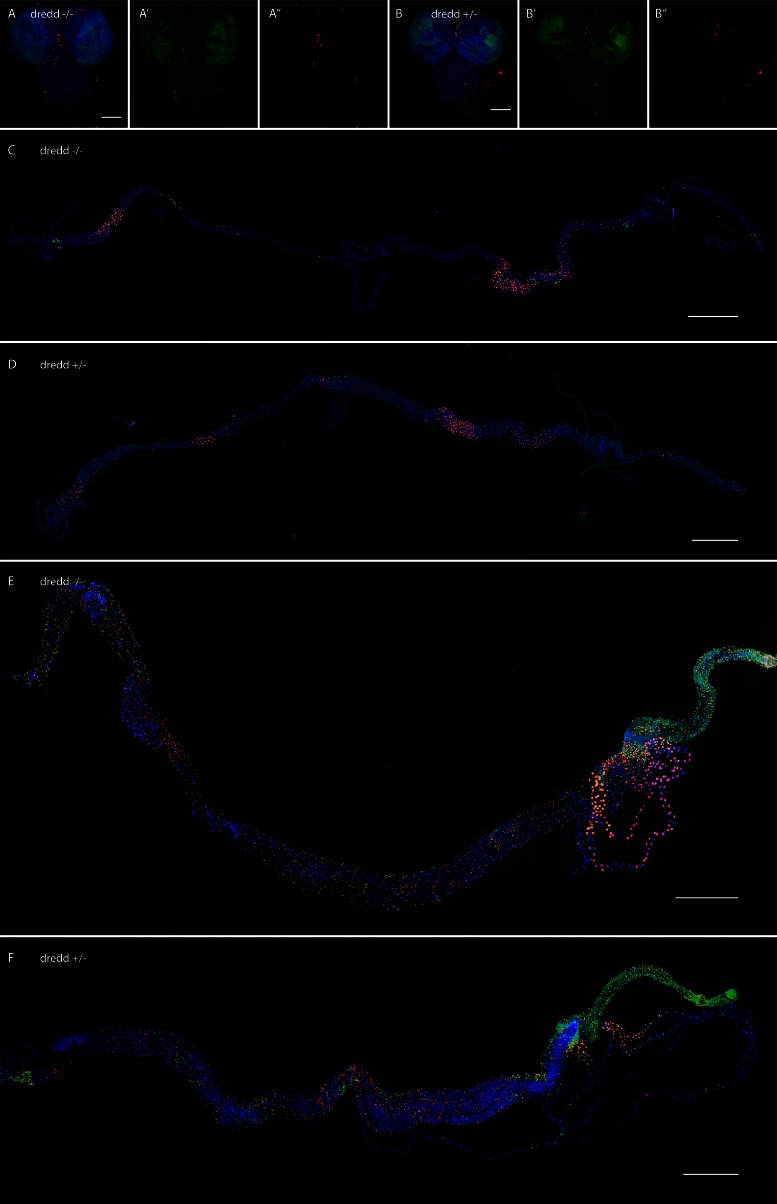
Loss of dredd does not change CasExpress patterns.(A–F) Confocal micrographs showing overlays of DAPI, RFP and GFP expression in third-instar larval CNS (A–B), larval intestines (C–D), and adult intestines (E–F). CasExpress and G-trace were crossed into heterozygous (A, C, E) or homozygous (B, D, F) dredd mutants. (A'–B') GFP only, (A''–B'') RFP only. Scale bars in A and B are 100μm, in C and D are 800μm, in E and F are 400μmDOI: